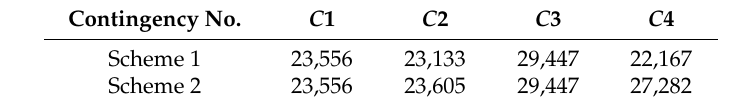
Table 2. Daily profit under different contingencies ($).